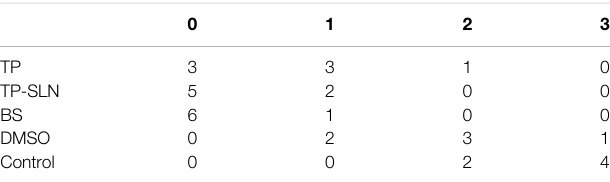
TABLE 4 | Pathological score of knee synovium in each group.